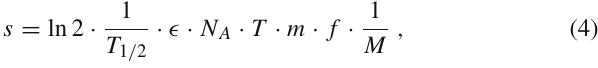
for the 643.5 keV γ -line of 232 Th double beta decay transition to the 0 + state. Significant spectral substructures are clearly visible in-between the main peaks due to the large number of recorded